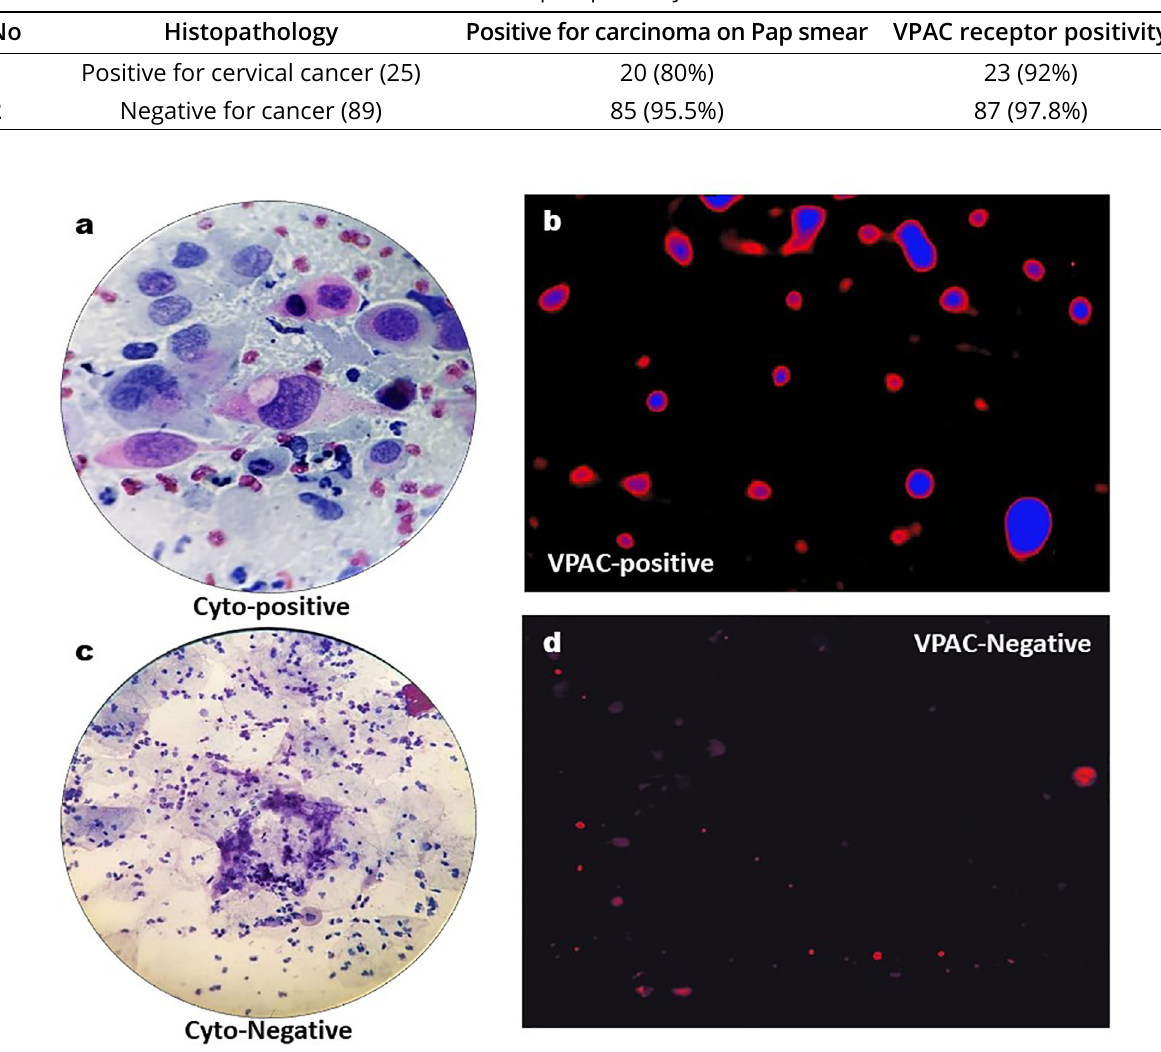
Figure 1. A. Cervical cytology shows pleomorphic keratinized squamous carcinoma and tadpole cells (Pap stain); B. VPAC receptor positive for malignancy; C. Cervical cytology shows normal epithelial cells with inflammation (Pap stain); D. VPAC receptor negative for malignancy.